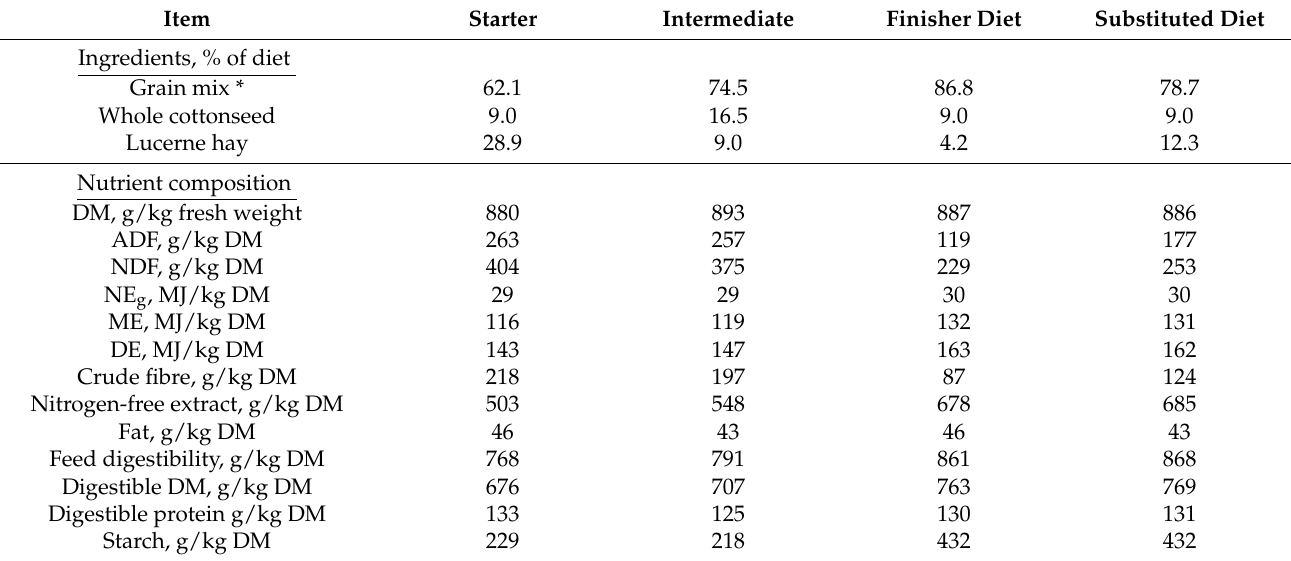
Table 2. Diet ingredients and nutrient composition for starter, intermediate, finisher and substituted diets fed to cattle.